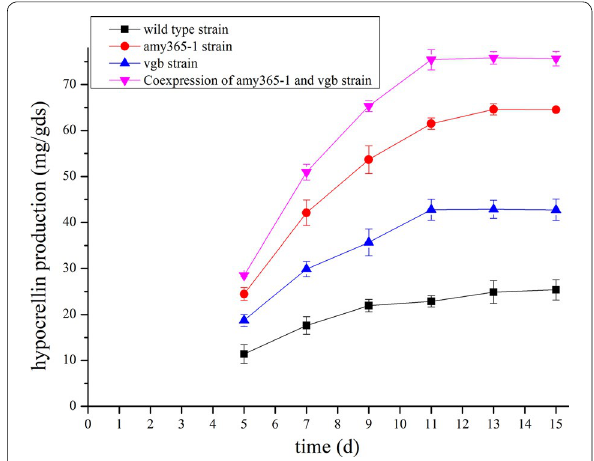
Fig. 4 Hypocrellin production cultured under SSF by three overex- pression transformants and wild type strain. The error bars represent standard deviation of triplicate measurements. Standard deviations were under 10 per cent of the